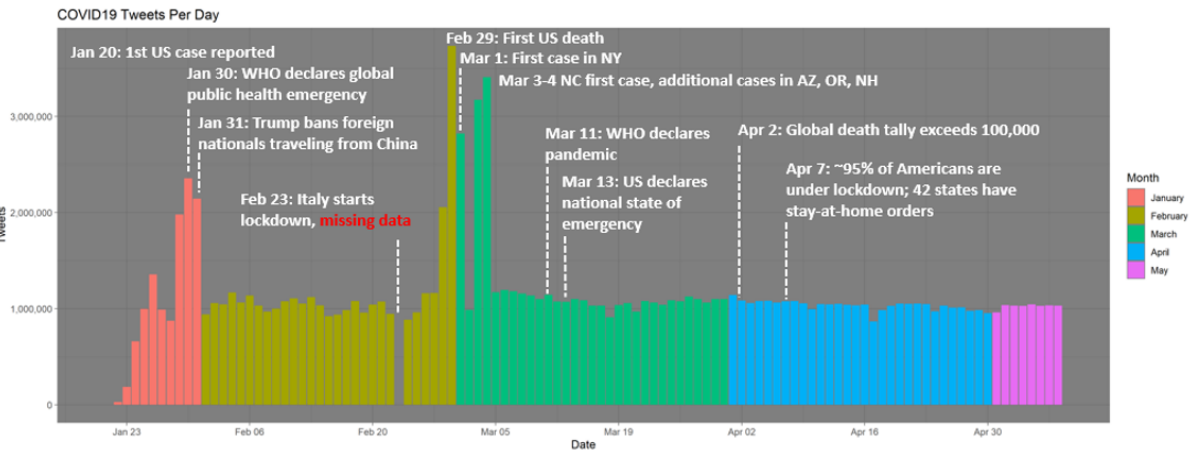
Figure 1. Volume of Twitter data collected during the study period. Twitter data were collected from January 21 to May 8, 2020, representing the first five months of the COVID-19 pandemic. We have annotated this timeline with major events to provide context during this early period of the pandemic. AZ: Arizona; NC: North Carolina; NH: New Hampshire; NY: New York; OR: Oregon; Trump: US President Donald Trump; US: United States; WHO: World Health Organization.